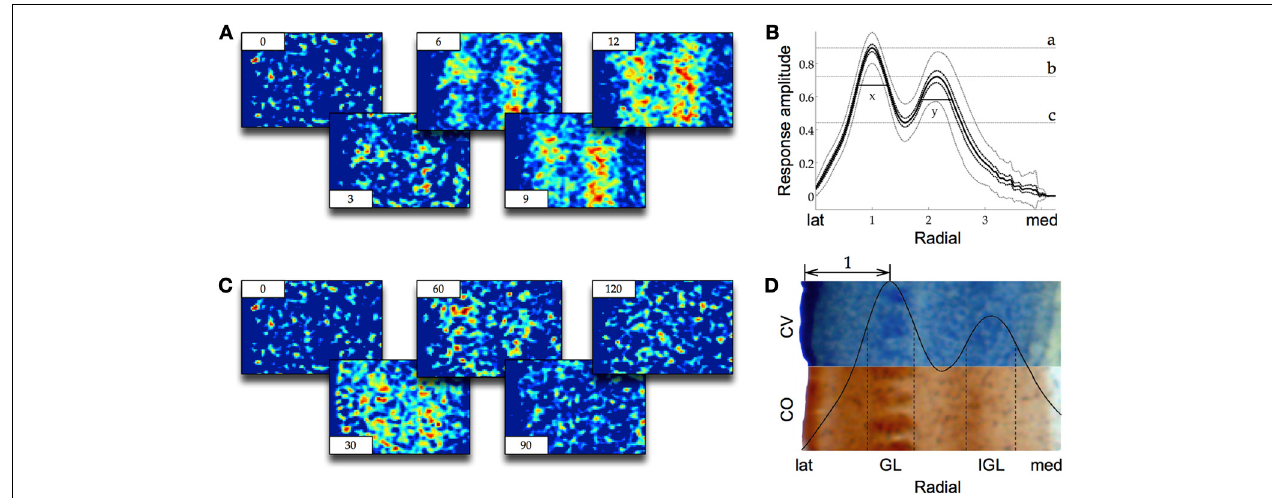
FIGURE 2 | (A) Representative screenshots of VSDI recording in barrel cortex during stimulation of VPM (averaged over 25 trials, 1000Hz frame rate, time in ms in corners, lateral to the left, see Figure 1A for orientation). Warmer colors from blue through green and yellow to red indicate higher response amplitudes. Two bands of activity (the GL on the left and the IGL on the right) appear and quickly reach their maximum amplitude over the course of the first few milliseconds (compare also to Figure 3 ). (B) Same as (A) but showing the decay of the signal over the course of 120ms. (C) The response in (A) normalized and averaged along the y-axis and across frames 7–16, n = 20. Black dotted lines are the s.e.m., gray dotted lines are the 95% ci. Irregularities toward medial are